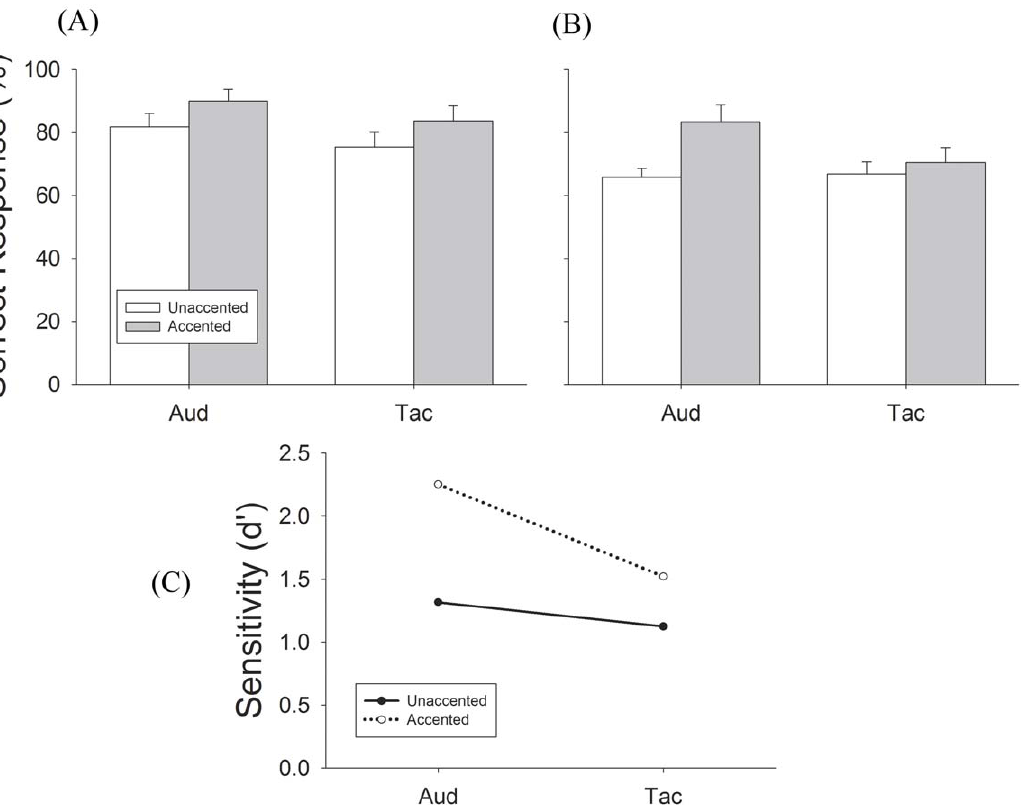
Figure 4. Results of Experiment 1, unimodal meter perception performance. (A) Performance for Triple-tending sequence. (B) Performance for Triple-tending sequence. Open bars represent unaccented condition, gray bars represent accented conditions. Error bars are Standard Error. (C) Solid line is unaccented metric note trials and dashed line is accented metric note trials.